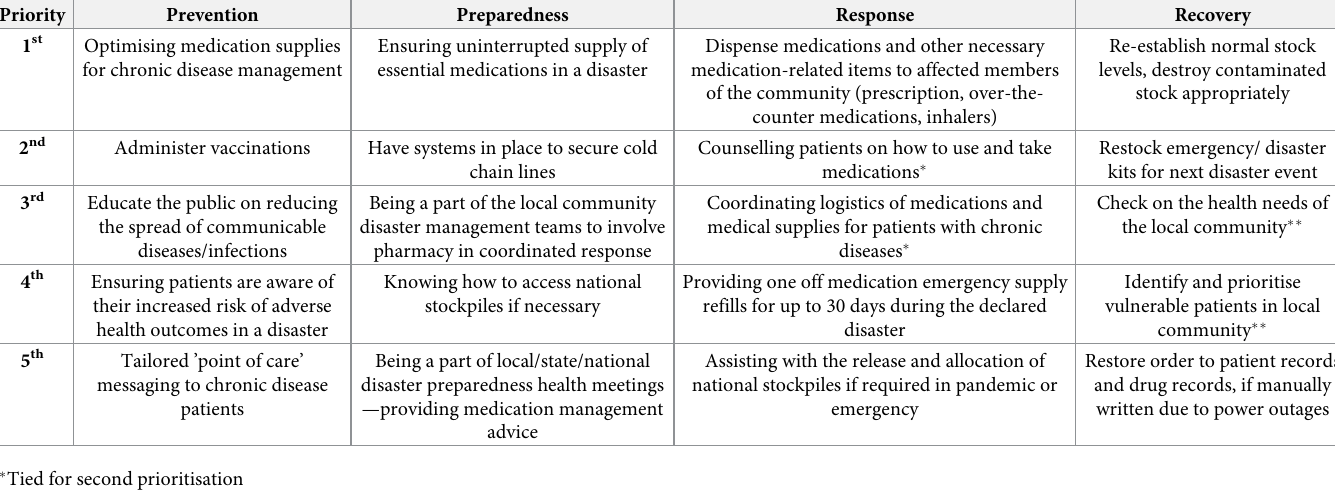
Table 6. Role prioritisation of pharmacists’ roles for the disaster PPRR phases obtained in round 1 of the Delphi study by the expert